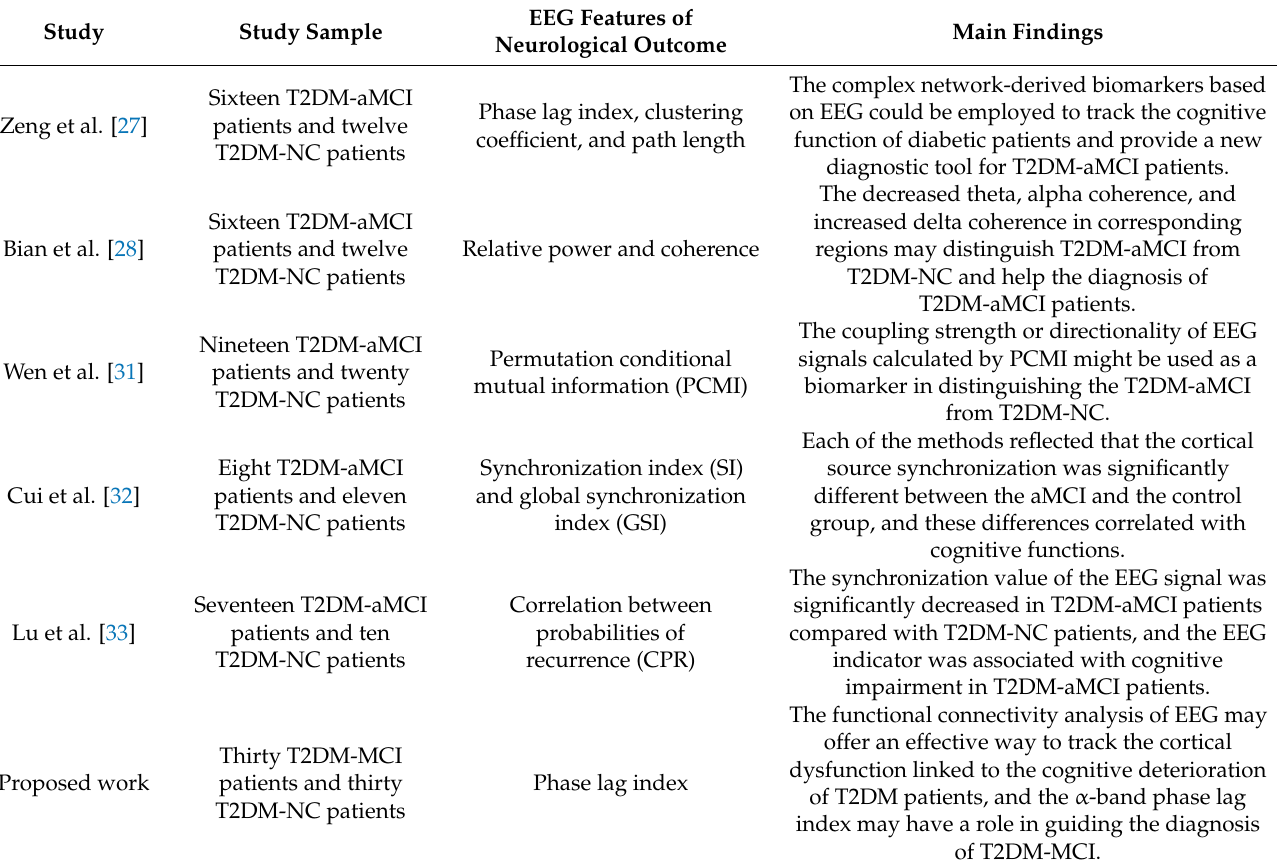
Table 3. Comparative study of methodologies and results between proposed work and previ- ous